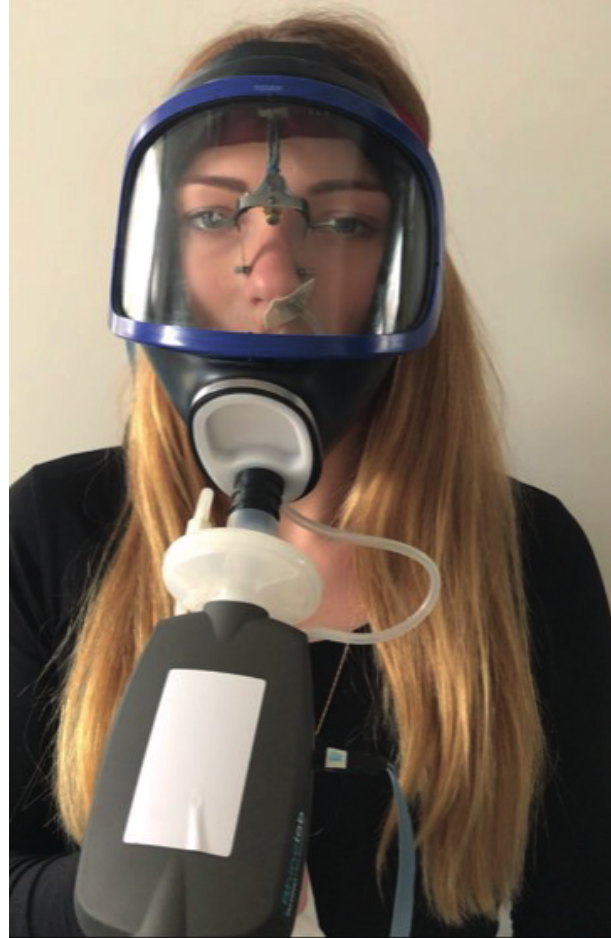
Figure 3. Measurement device under a full-face mask with rhinomanom- eter